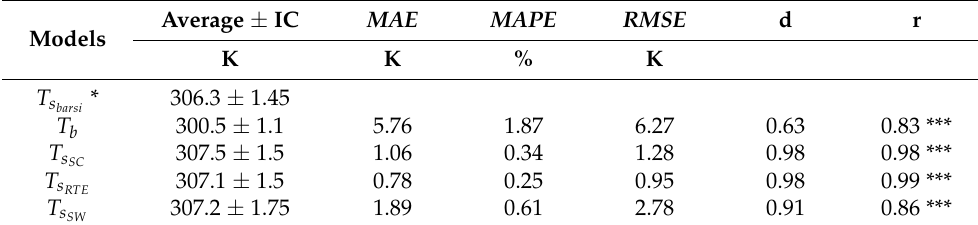
Figure 4. Relation of ( A ) the surface temperature corrected by the Barsi model ( T s ; K) and brightness temperature ( T b ); ( B ) the surface temperature corrected by the single-channel model ( T s ; K); ( C ) the surface temperature corrected by the radiative transfer equation model ( T s ; K); and ( D ) the surface temperature corrected by the split-window model ( T s ; K). Table 5. Average ( ± 95% confidence interval) of the surface temperature corrected by the Barsi model ( T s ; K), used as reference values, and average ( ± 95% confidence interval), mean absolute error barsi ( MAE ), mean absolute percent error ( MAPE ), root mean square error ( RMSE ), Willmott coefficient (d) and Pearson correlation coefficient (r) of the surface temperature corrected by the single-channel model ( T s ; K), the radiative transfer equation model ( T s ; K), and the split-window model ( T s ; RTE SC SW K). Values with (***) indicate p -value <